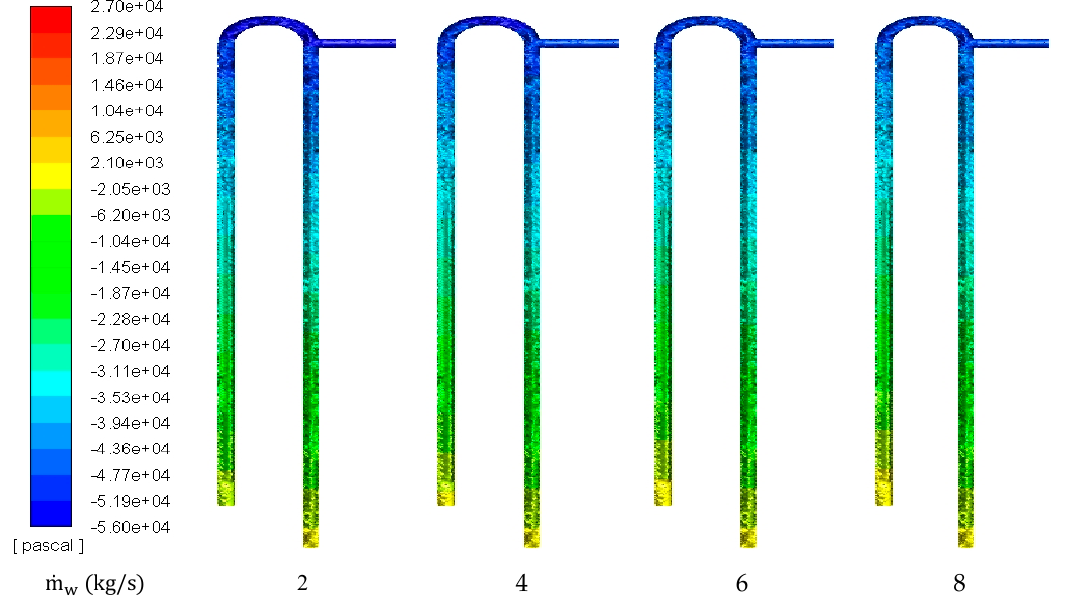
Figure 11. Pressure contours at di ff erent flow ratios and X w = 4306.59, α m = 0.2 and X v = 0.1. Figure 11. Pressure contours at different flow ratios and X (cid:2933) = 4306.59, α (cid:2923) = 0.2 and X (cid:2932) = 0.1. Figure 11. Pressure contours at different flow ratios and X (cid:2933) = 4306.59, α (cid:2923) = 0.2 and X (cid:2932) = 0.1.